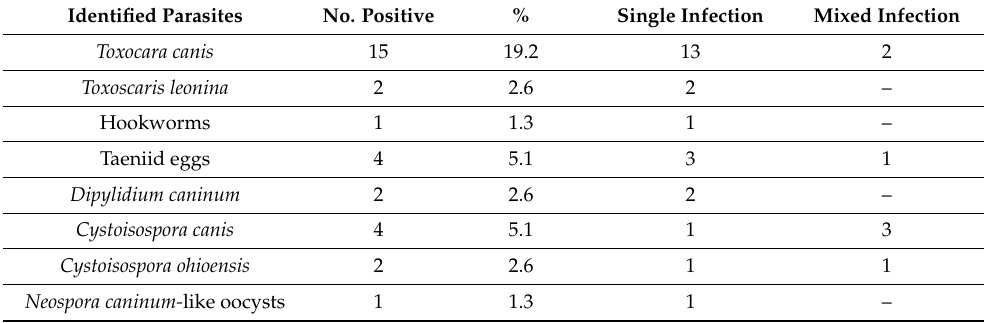
Table 1. Prevalence of different parasites in feces of 78 stray dogs from Dakahlia governorate, Egypt.